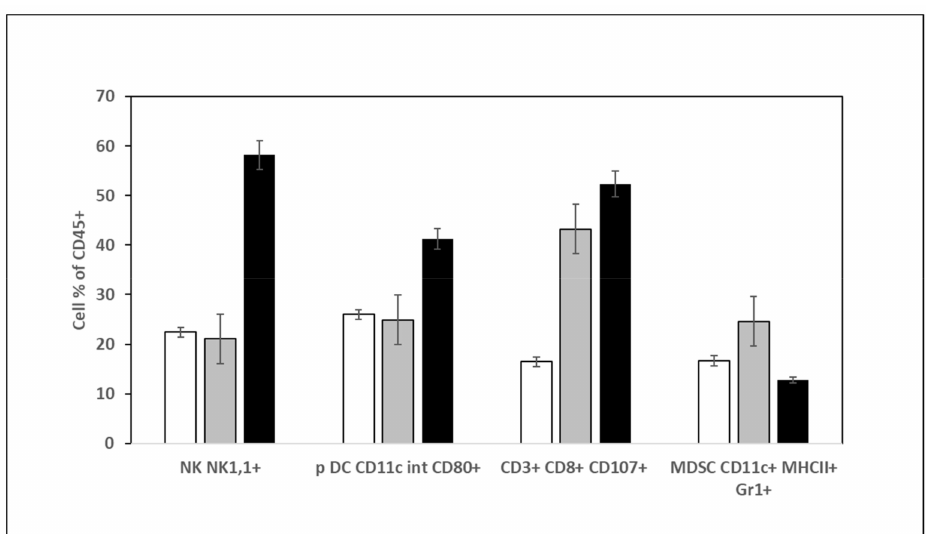
Figure 5. Quantification of immune cells in the tumor of mice treated either with PBS, DSC or DSS at 5 mg / kg. Cells extracted from tumors were processed for immunophenotyping and analyzed by flow cytometry. White: Non-treated mice; grey: DSS treated mice; black: DSC treated mice.